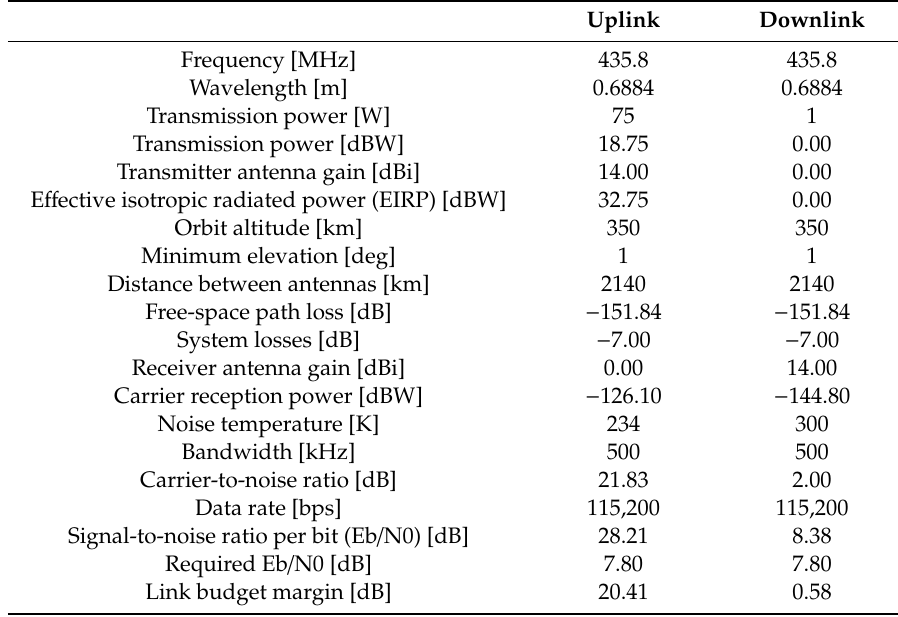
Table 3. SE01’s link